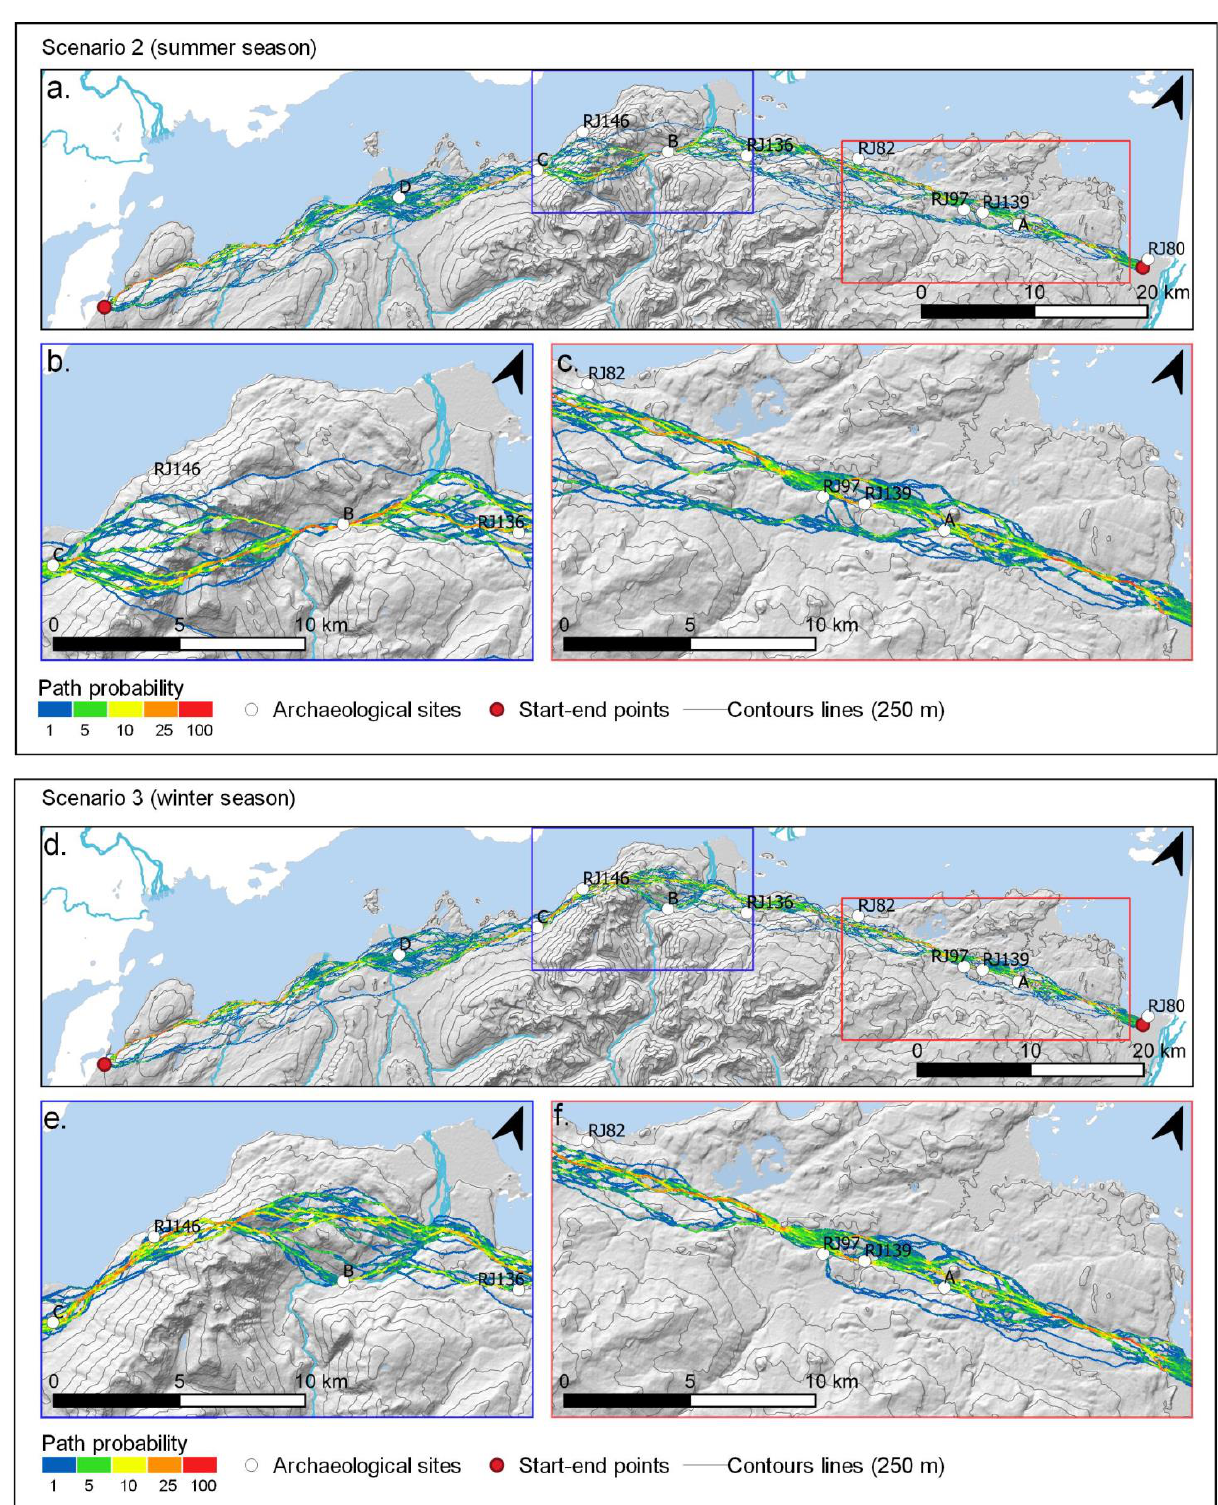
Figure 6. Summer ( a ) and winter ( d ) simulated corridors incorporating uncertainties in the cost surface. Specific clusters are presented: the Paso las Llaves sector (purple box: b , e ) and Chile Chico town (initial point) to the La Tina rock shelter (red box: c , f ). Archaeological sites: Chile Chico 1: RJ80; La Tina rock shelter: RJ82; Casa Piedra: RJ136; chenque El Baño: RJ139; Guanaca y Luna: